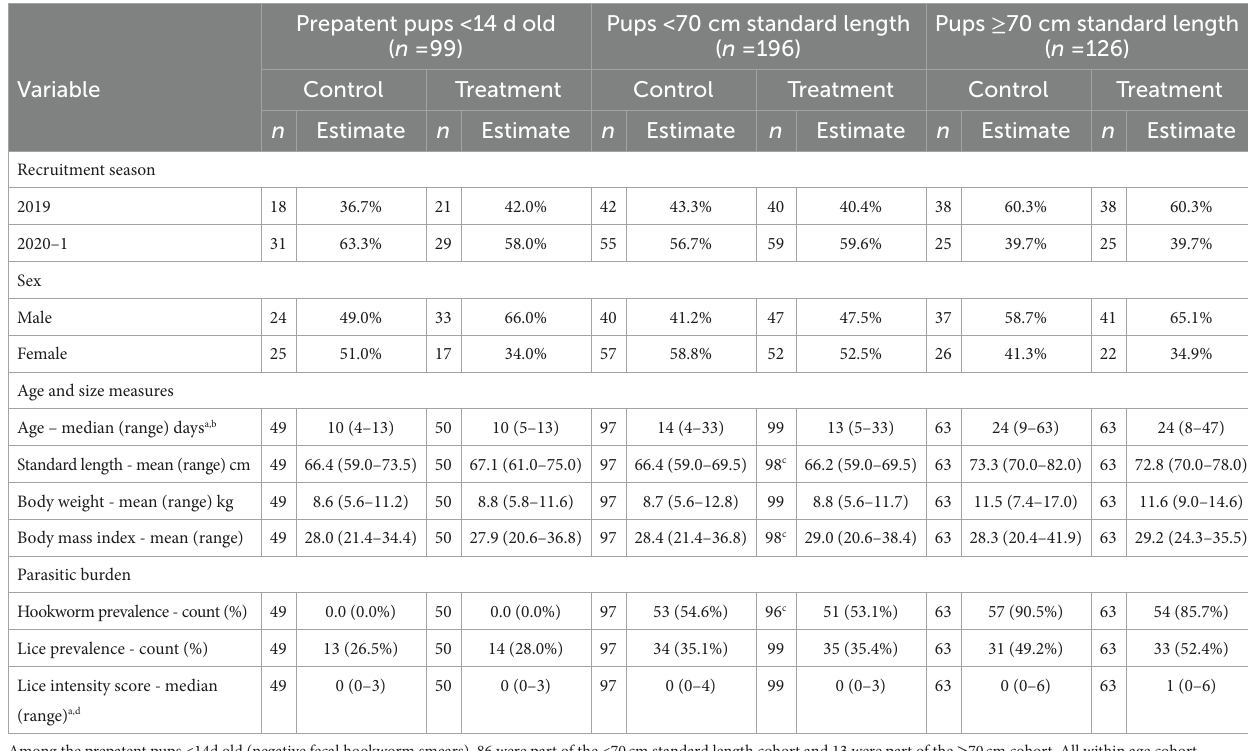
TABLE 1 Recruitment season, demographics, and health details for treatment groups of Australian sea lion pups for each age